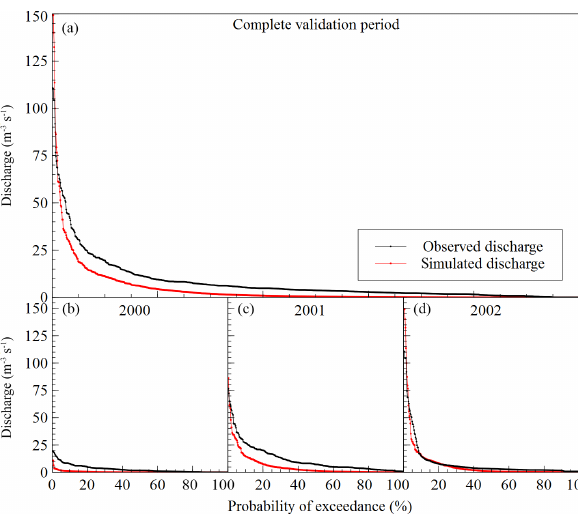
Figure 8. Observed (in black) and simulated (in red) flow duration curves (FDCs) for the whole validation period (a) and for the corre- sponding 3 years in isolation ( b , c and d ) for the years 2000, 2001 and 2002,